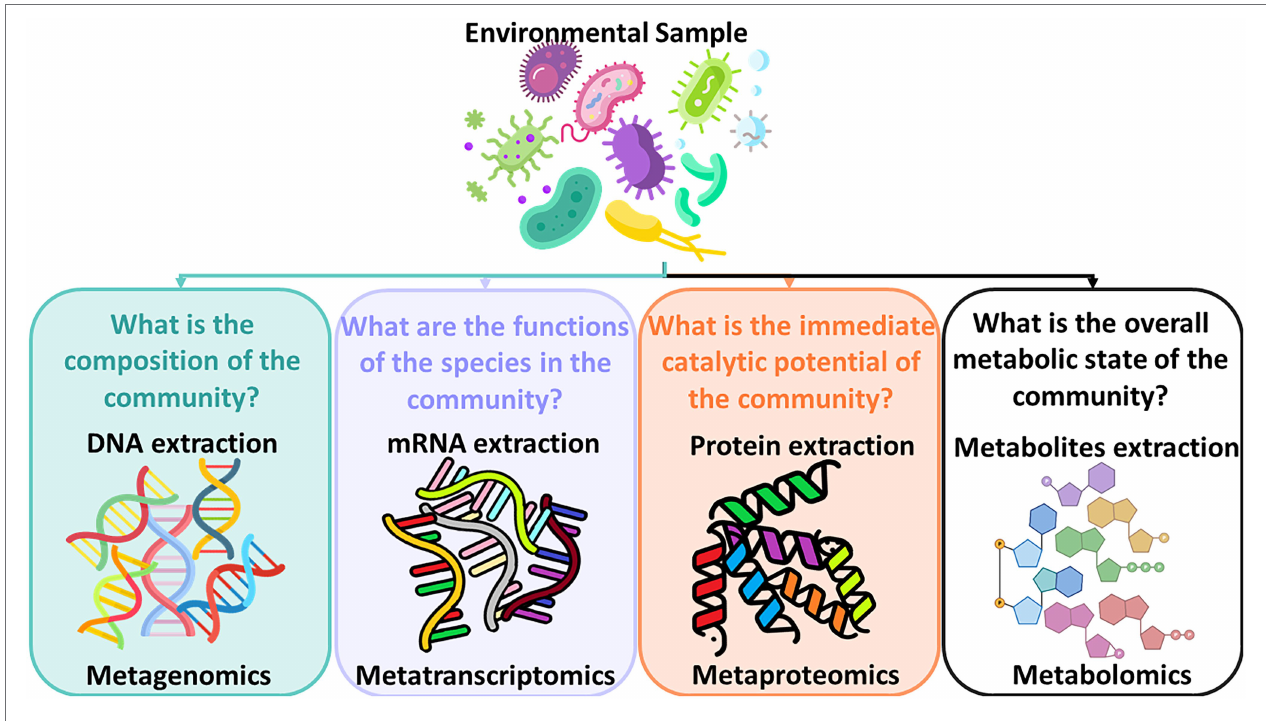
FIGURE 1 | Subfields of meta-omics and the questions they